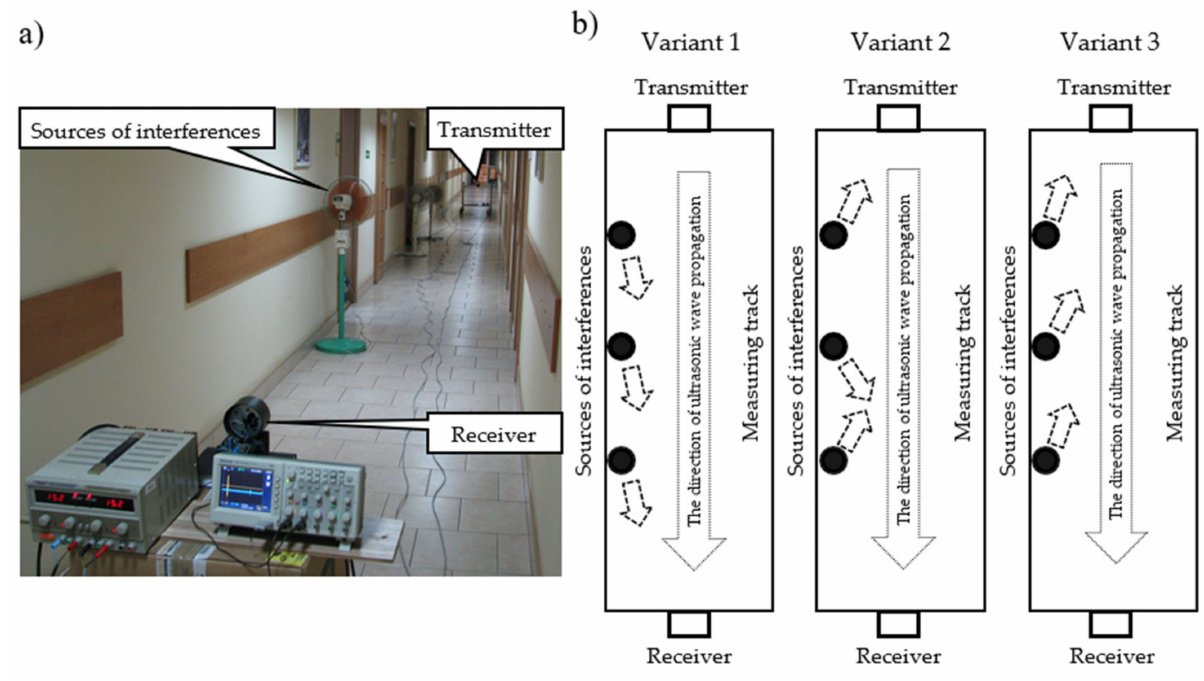
Figure 13. ( a ) The test setup; ( b ) variants of arrangement of the interference